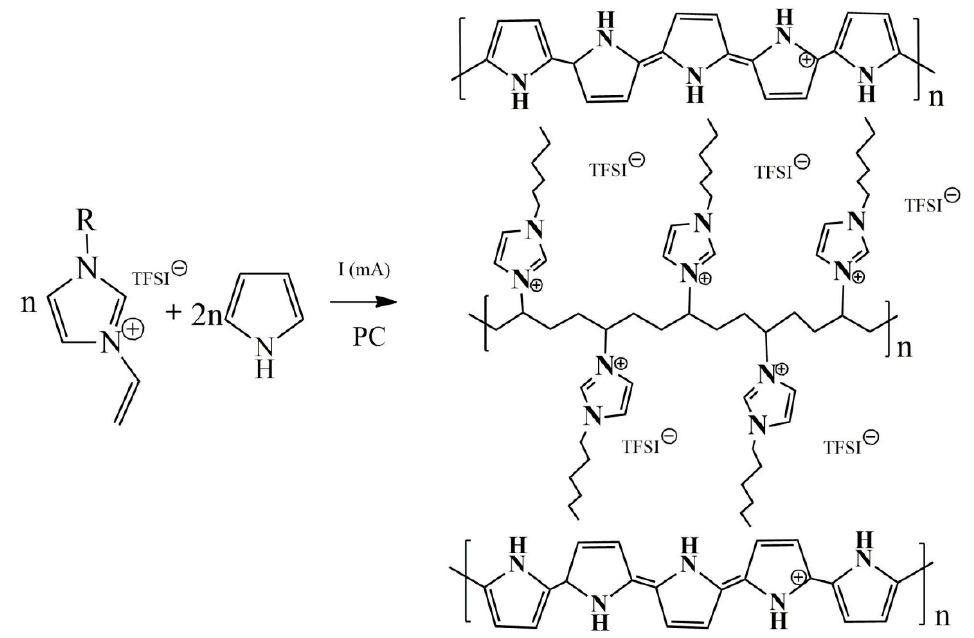
Figure 3. Structure of the proposed PPyPIL blends formed during the electropolymerization of pyrrole and PIL monomer in PC.